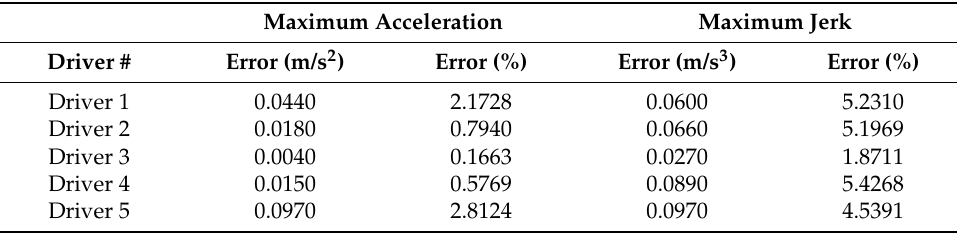
Table 5. Evaluation of the feature similarities between the experiments and